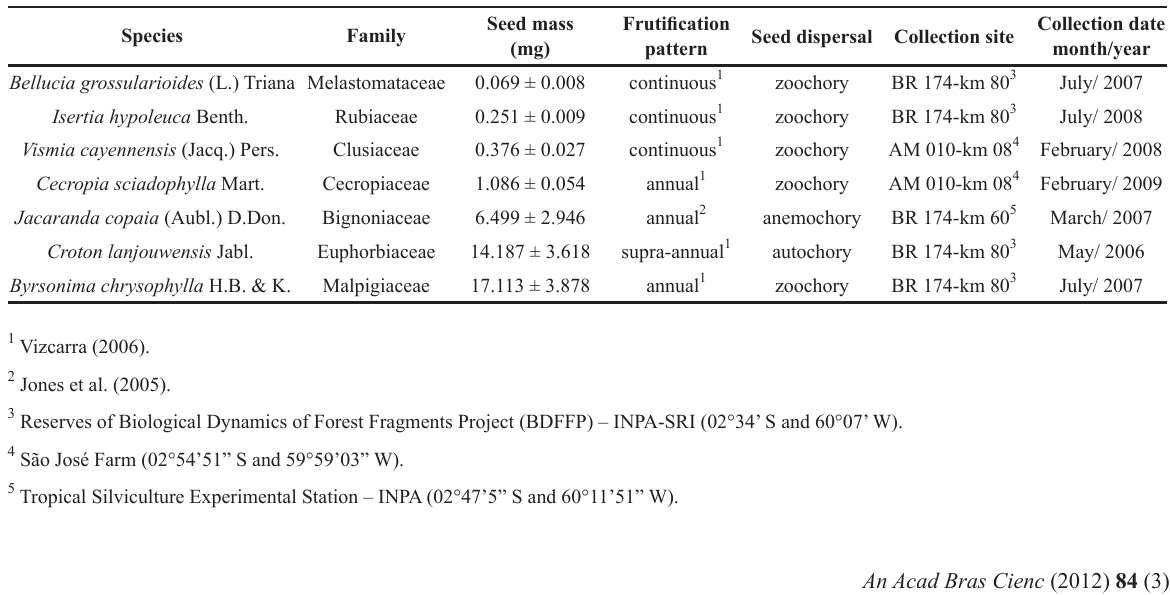
Seed fresh mass, fruiting pattern, seed dispersal, collection site and collection dates of seven woody pioneer species of the Central